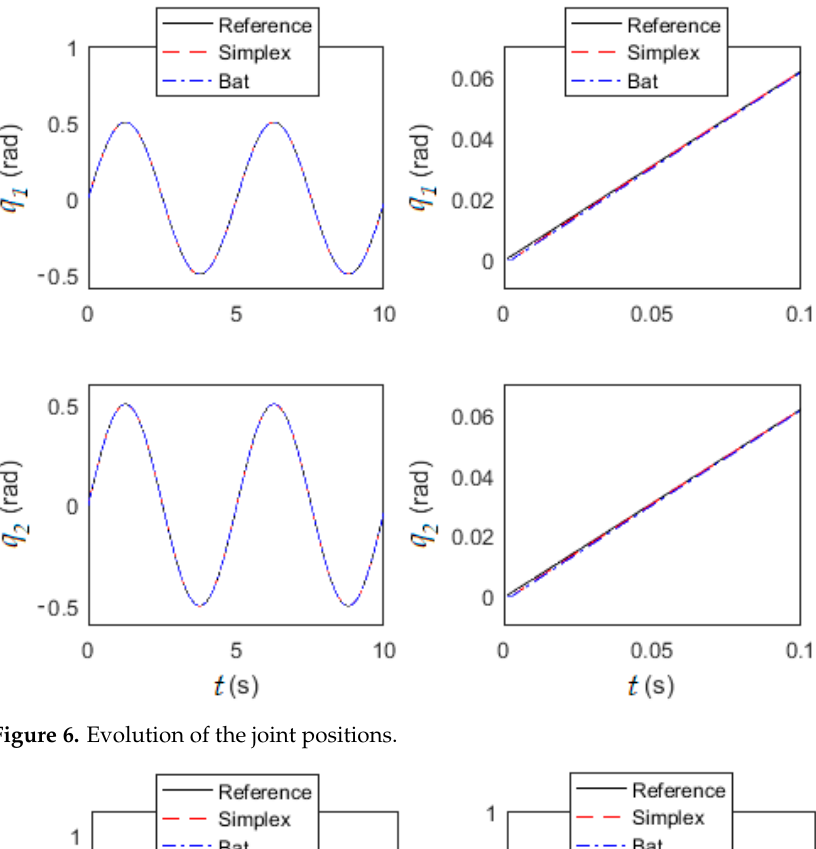
Figure 5. Evolution of the forces.